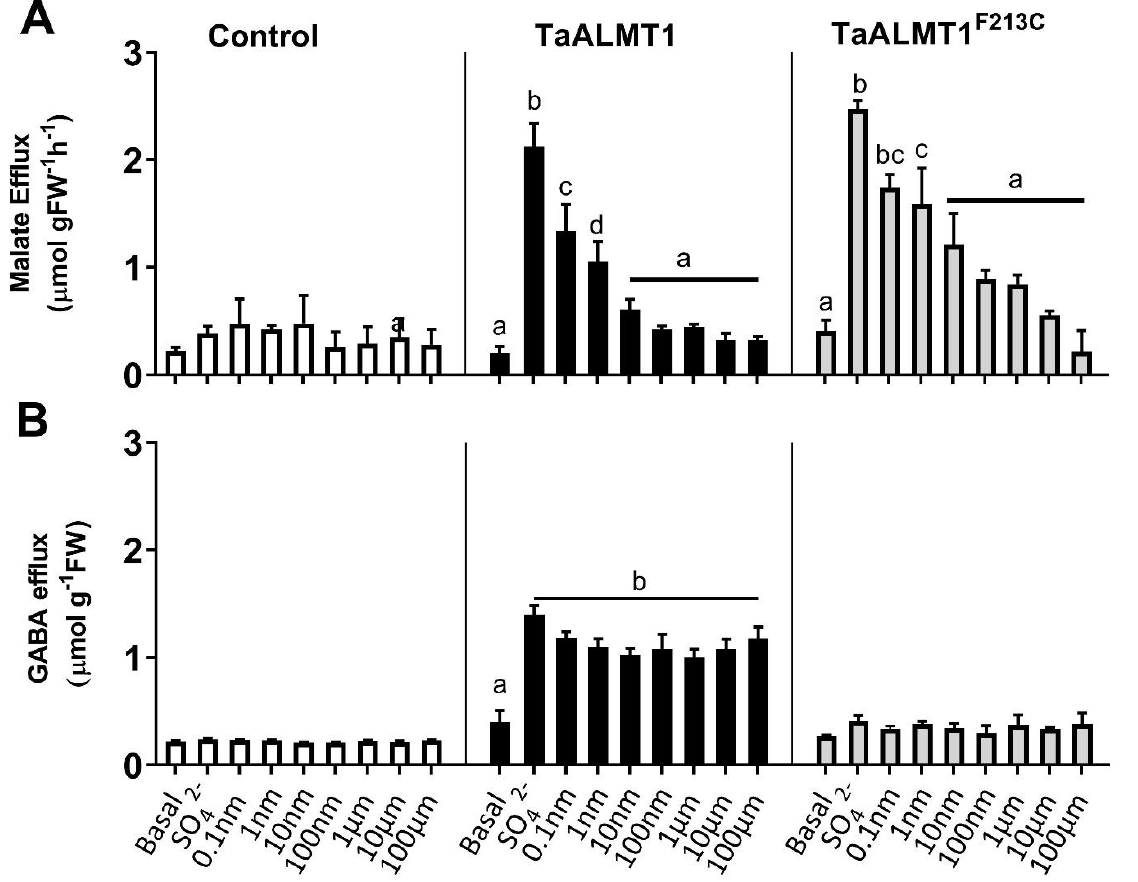
Figure 3. Inhibition of malate ( A ) efflux but not GABA efflux ( B ) from tobacco BY2 cells expressing TaALMT1 or the mutant TaALMT1 F213C by picrotoxin. Malate and GABA efflux were activated by Na 2 SO 4 (SO 42 − 10 mM; pH 7.5), and the effects of picrotoxin were tested in combination with Na 2 SO 4 solution at concentrations ranging from 0.1 nM to 100 μM. Data are displayed as means ± SE ( n = 3). Different letters represent significant differences between treatments using one-way ANOVA.